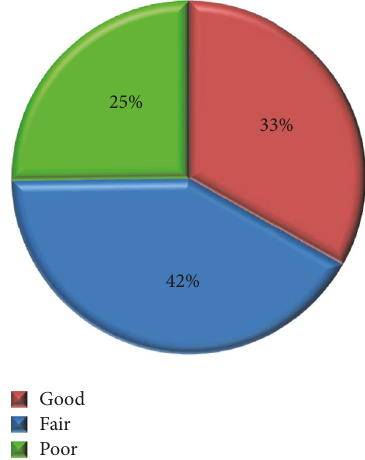
Figure 1: Oral hygiene status of the study